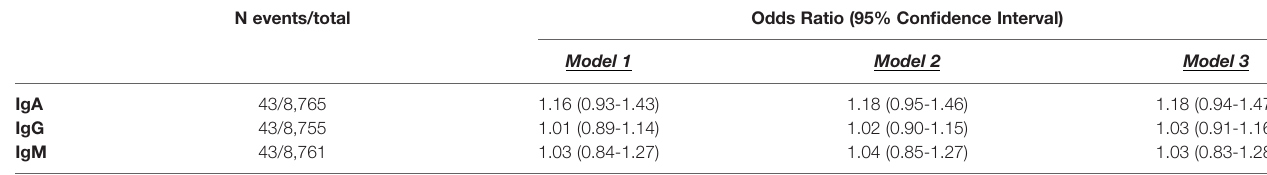
TABLE 2 | Association between serum immunoglobulins and prevalent pneumonia.